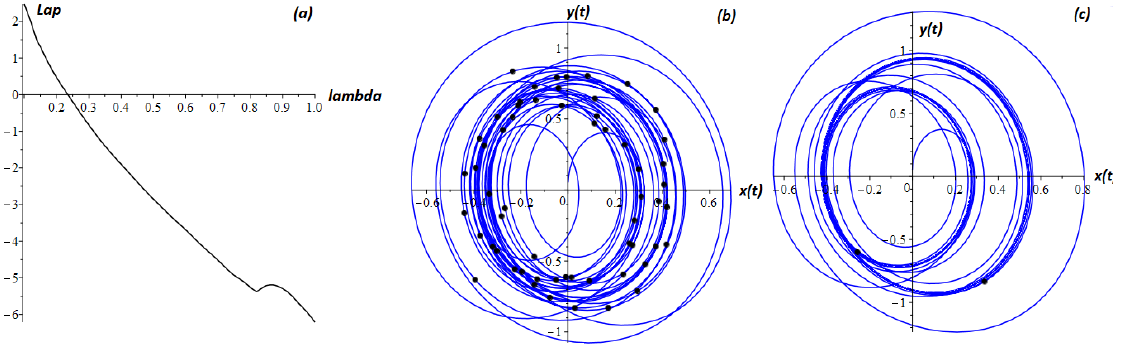
Figure 7. The spectrum of Lyapunov exponents from λ ( a ) and phase trajectories at ( b ) λ = 0.18, ( c ) λ = 0.6. The dots represent the Poincaré